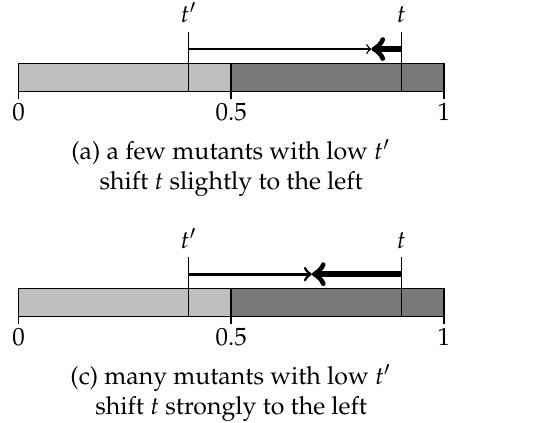
Figure 7. Dynamics under “AVG